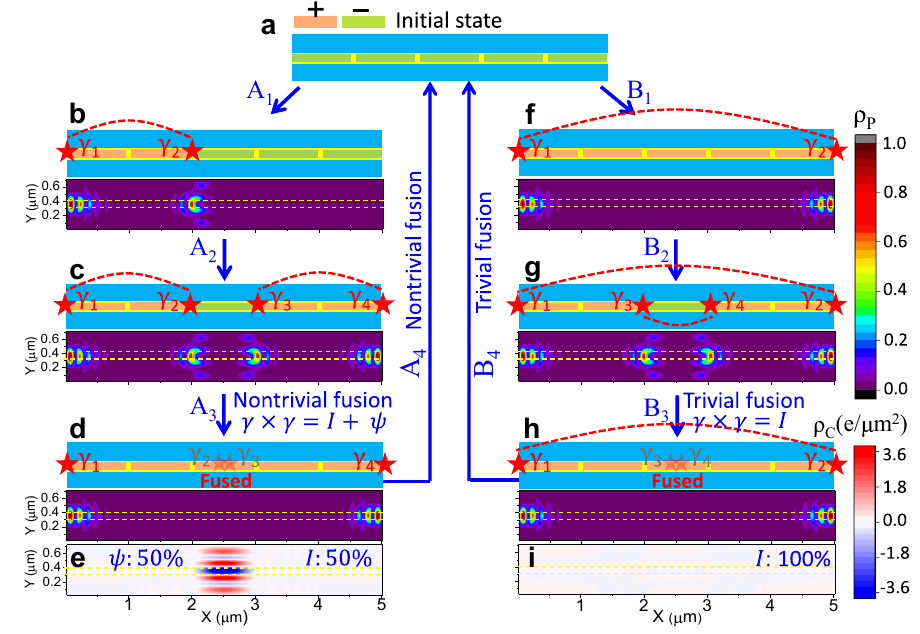
Fig. 5 Probing non-Abelian statistics through MBS fusion in an SJ. The scheme is supported by the calculated probability and charge densities, ρ P and ρ C . The red dashed lines link the same MBS pair, the yellow dashed lines indicate the N region covered by the mini gates. a Initial trivial state with − − − − − mini gates. b A 1 : changing − − − − − into + + − − − , MBS pair ( γ 1 , γ 2 ) is created. c A 2 : changing + + − − − into + + − + + , a second MBS pair ( γ 3 , γ 4 ) is created. d A 3 : changing + + − + + into + + + + + , the MBS ( γ 2 , γ 3 ) are nontrivially fused at the center, accessing both vacuum, I , and an unpaired fermion, ψ , with 50% probability. For I , the system has no extra charge, supported by the vanishing ρ C in i for the ground state after the fusion. For ψ , the system has an extra charge, supported by the fi nite sum of ρ C in e for the ground and fi rst excited states after the fusion. f B 1 : changing − − − − − into + + + + + , the MBS ( γ γ + + + + + into + + − + + , a second MBS pair ( γ γ + + − + + into 1 , 2 ) are created. g B 2 : changing 3 , 4 ) is created. h B 3 : changing + + + + + , the MBS ( γ γ I with 100% probability. A + + + + + to − − − − − , the remaining MBS 3 , 4 ) are trivially fused, corresponding to 4 or B 4 : changing pair is fused and the system returns to the initial mini-gate con fi guration. MBS fusion can be repeated following such operations. ρ P is normalized to its maximum. The (minimum and maximum) values in e , i are ( − 3.5, 2.9) and ( − 0.00009, 0.00004), respectively. All parameters are taken from Fig.